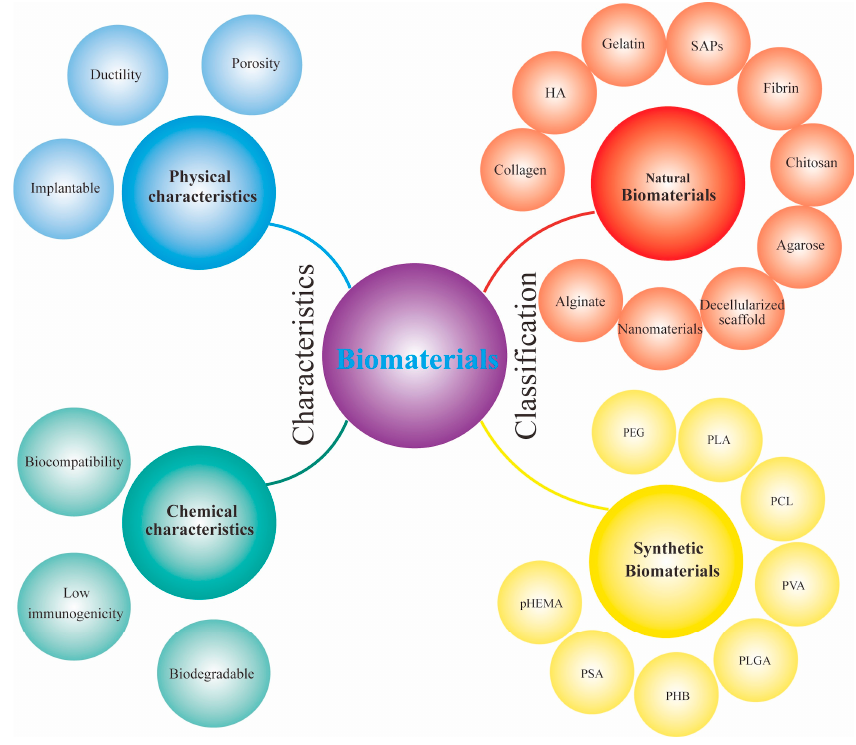
Figure 3. Characteristics and classification of biomaterials. Table 1. The bioactivity of natural biomaterials in various models of